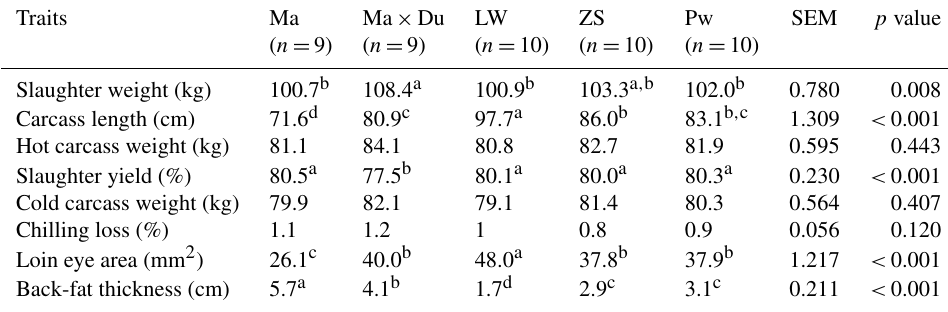
Table 5. Production parameters of genotypes. Traits Ma Ma × Du LW